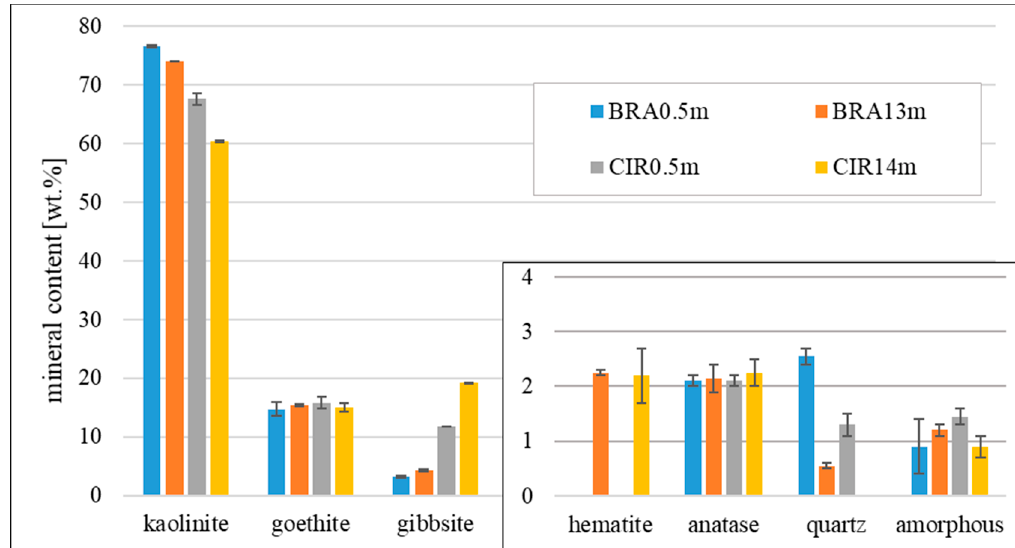
Figure 4. Mineralogical quantification of selected samples by XRPD-Rietveld. The results are the triplicate average shown with the standard deviation bars.